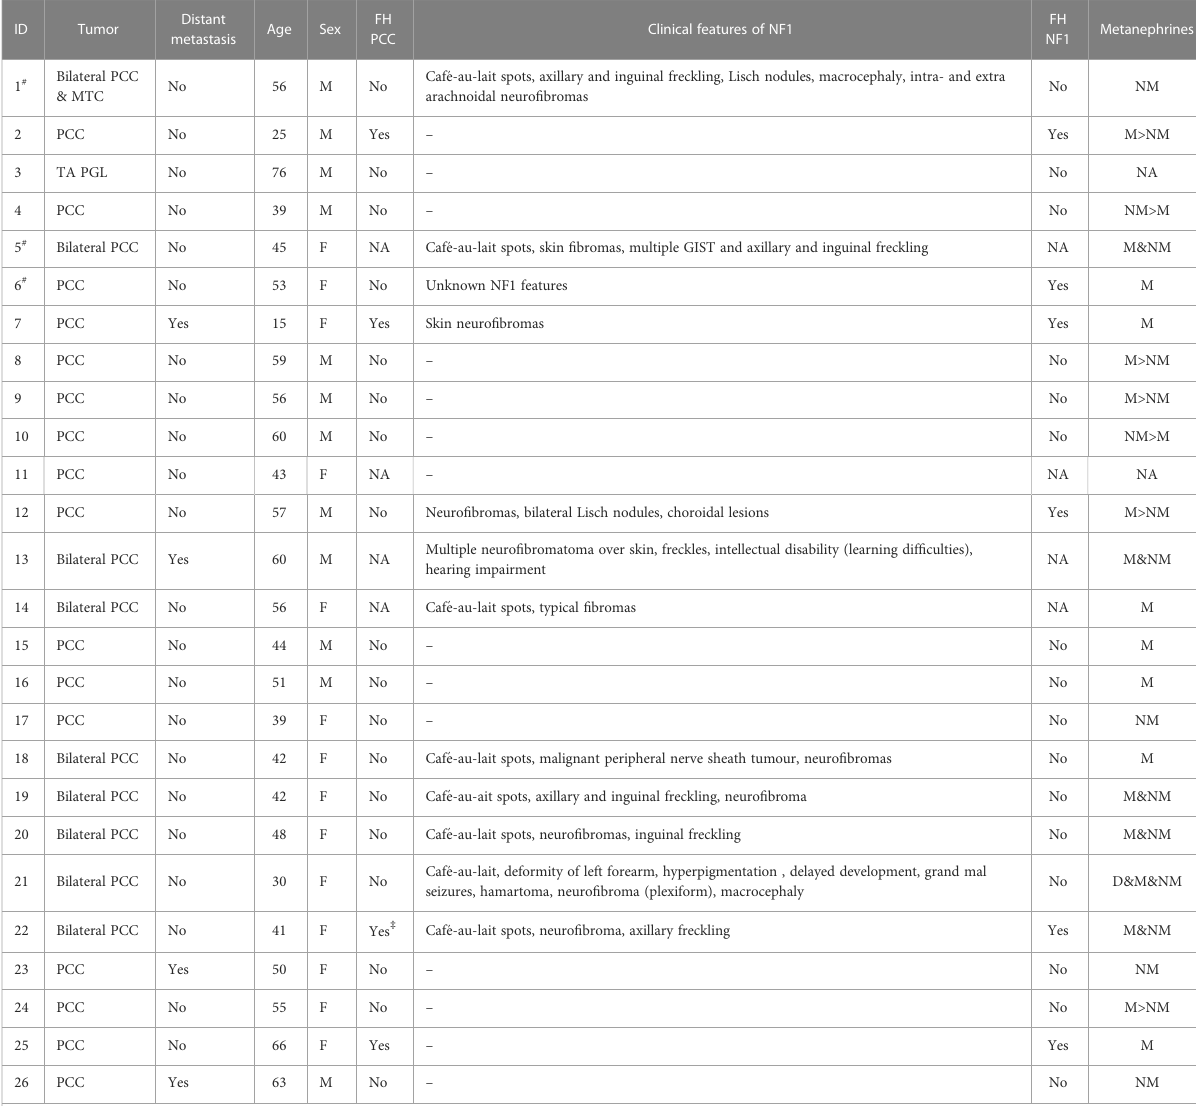
TABLE 2 Clinical data of the patients included in the